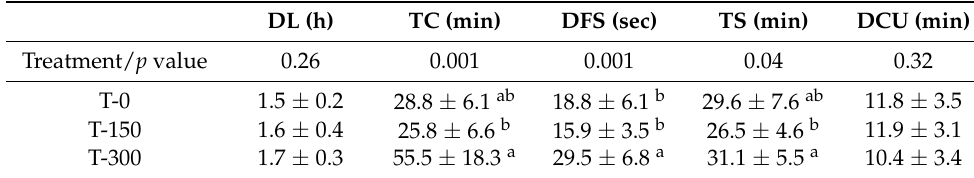
Table 3. Mother–young bonding, assessed within the first hours of life, in French Alpine goats that had received 0 (T-0), 150 g/head daily (T-150), or 300 g/head daily (T-300) of energy supplement during the last third of